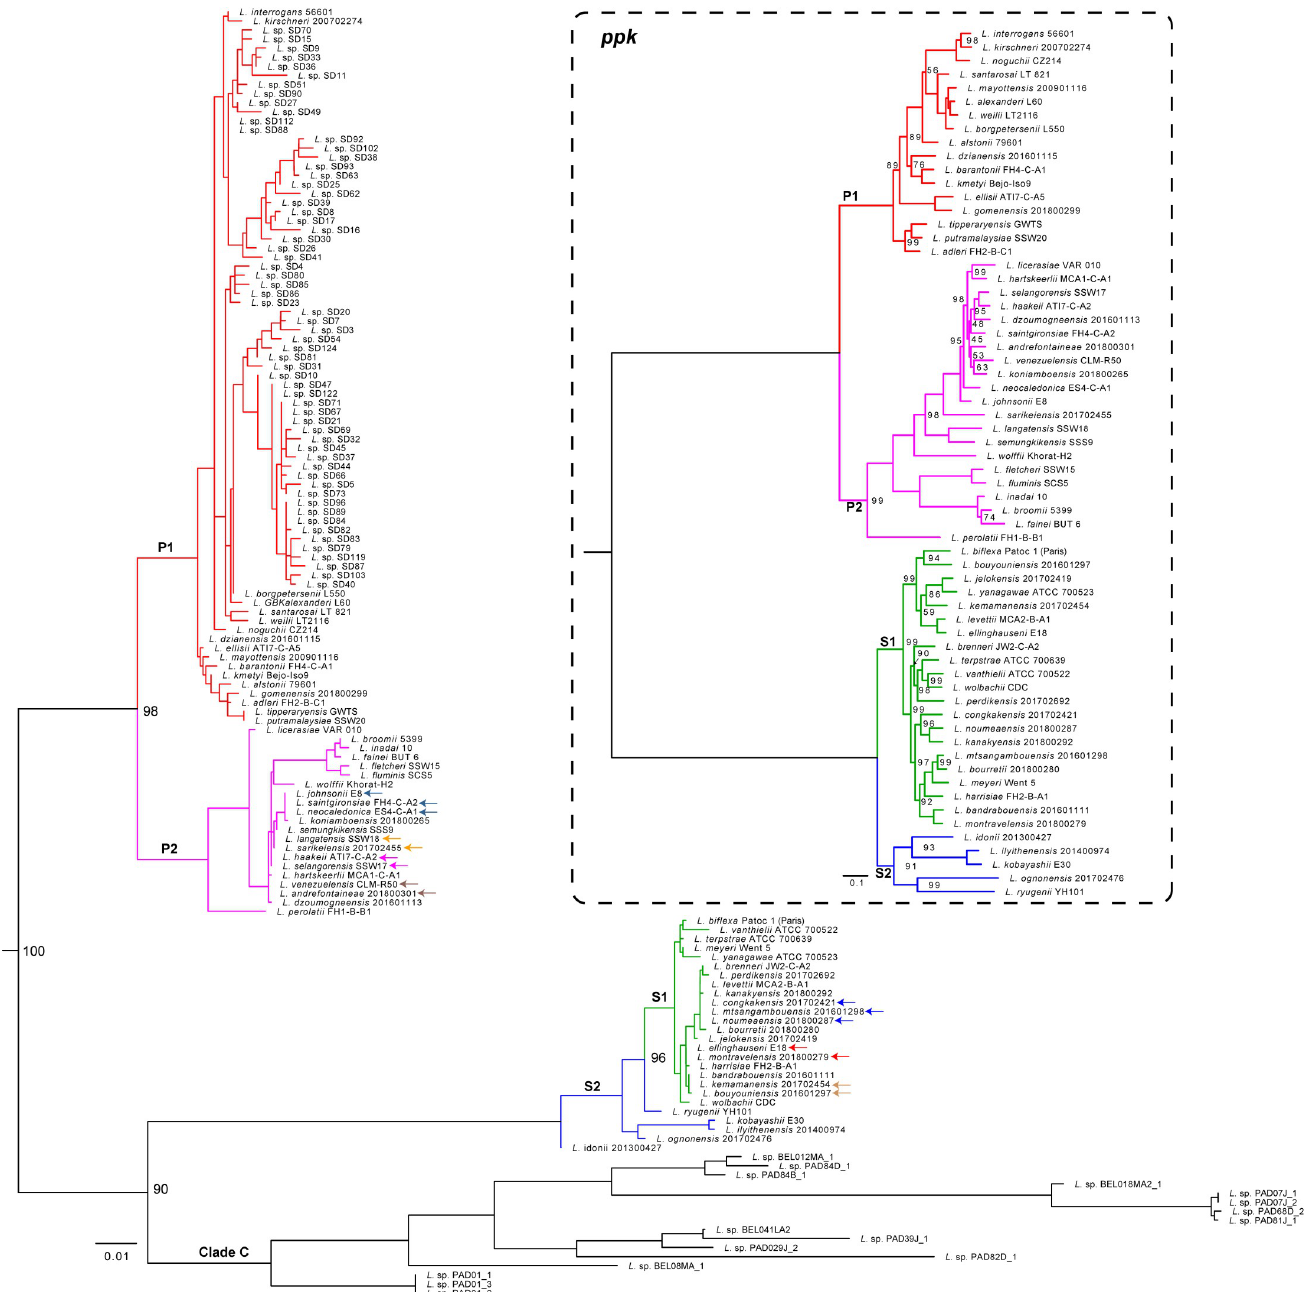
Fig 8. Phylogenetic tree based on the 16S rRNA and ppk sequences to evaluate the diversity within the Leptospira genus. In addition to the 16S rRNA sequences from the 64 genomes investigated in the present study, those from uncultured strains from the Peruvian Amazon (Clade C) [26] and from insectivorous bats from eastern China [27] were added. The branches are colored according to their belonging to the four main subclades: P1 (red), P2 (purple), S1 (green) and S2 (blue), while the strains of the “clade C” are in black. For the sake of clarity, the bootstrap values are only indicated for the nodes that correspond to the major splits. A tree constructed with the ppk gene sequences is included in the dashed box for comparison. In this case, all bootstrap values less than 100 are indicated at the different